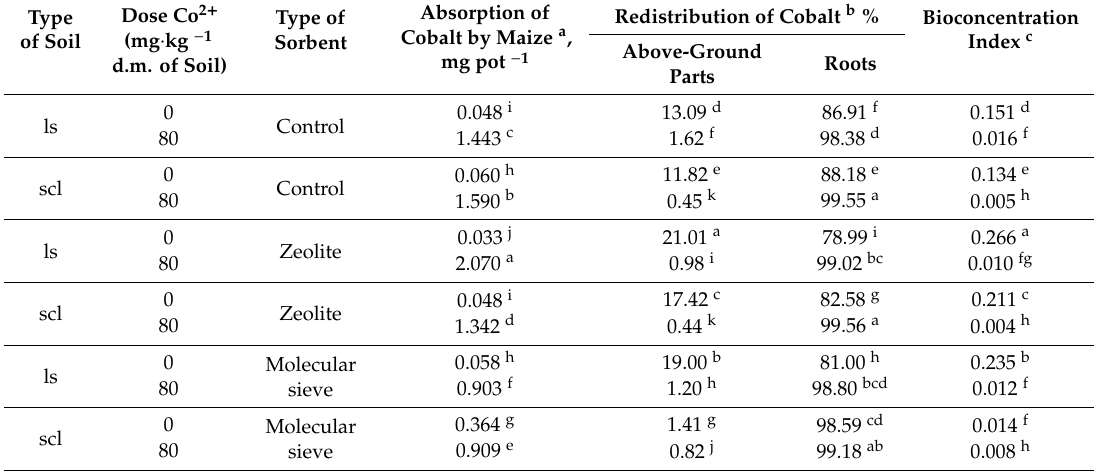
Table 15. Absorption, redistribution, and bioconcentration of cobalt in a plant. Type of